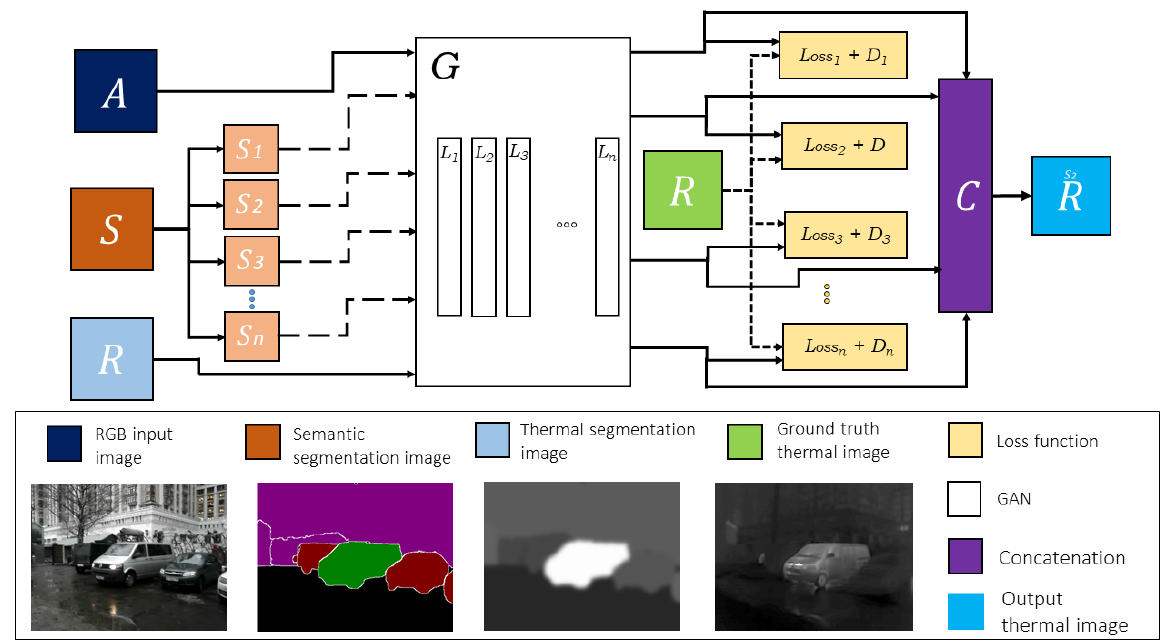
Figure 3. The pipeline of the second approach.